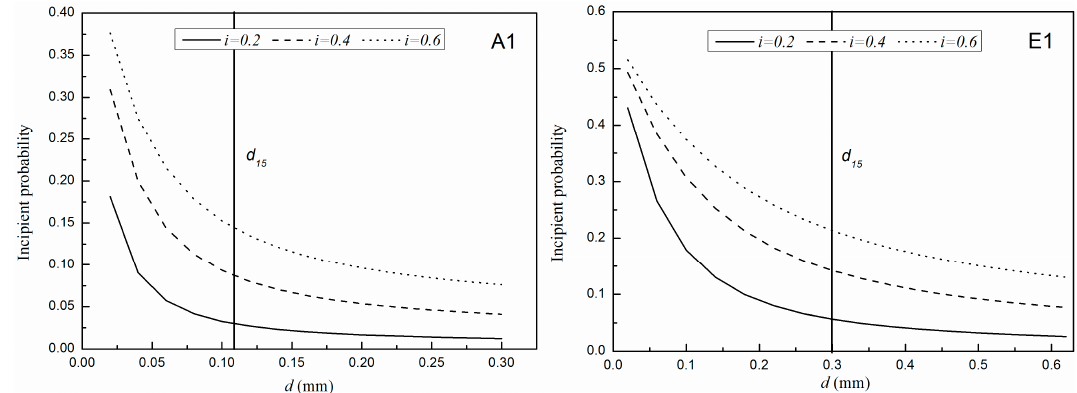
Figure 10. Initiation probability of different particles.